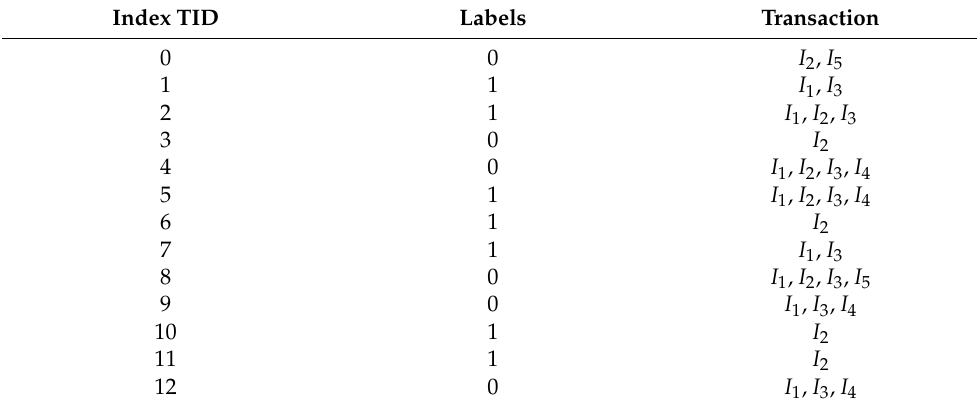
Table 4. Transaction dataset with